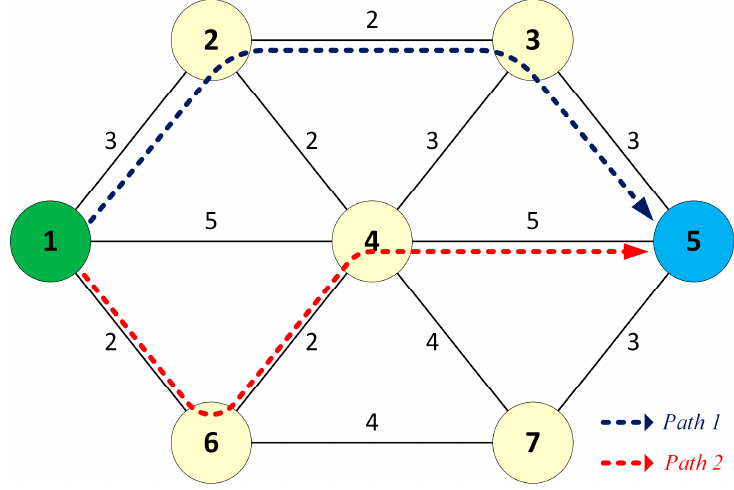
Figure 2. The dual separate paths (DSPs) from source 1 to destination 5.